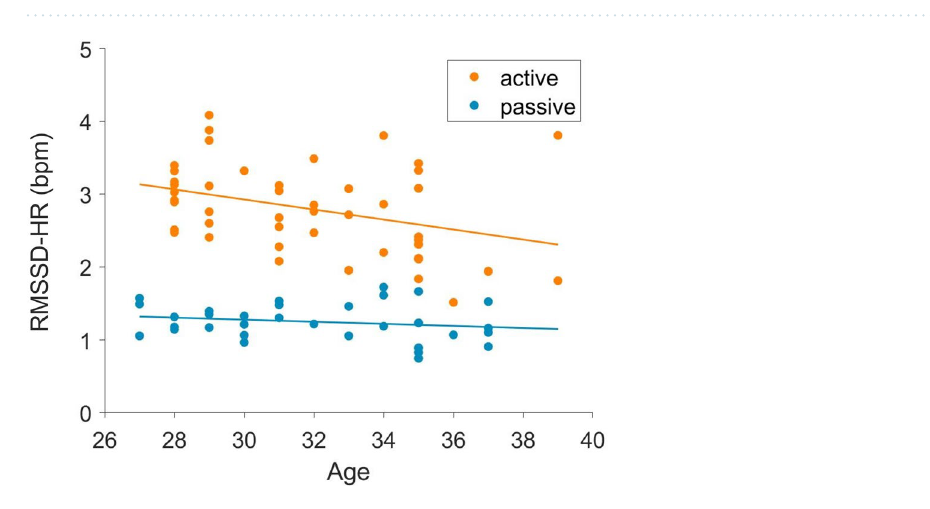
Figure 4. Receiver operating characteristics (ROC) curve for ( a ) early gestation and for ( b ) late gestation.